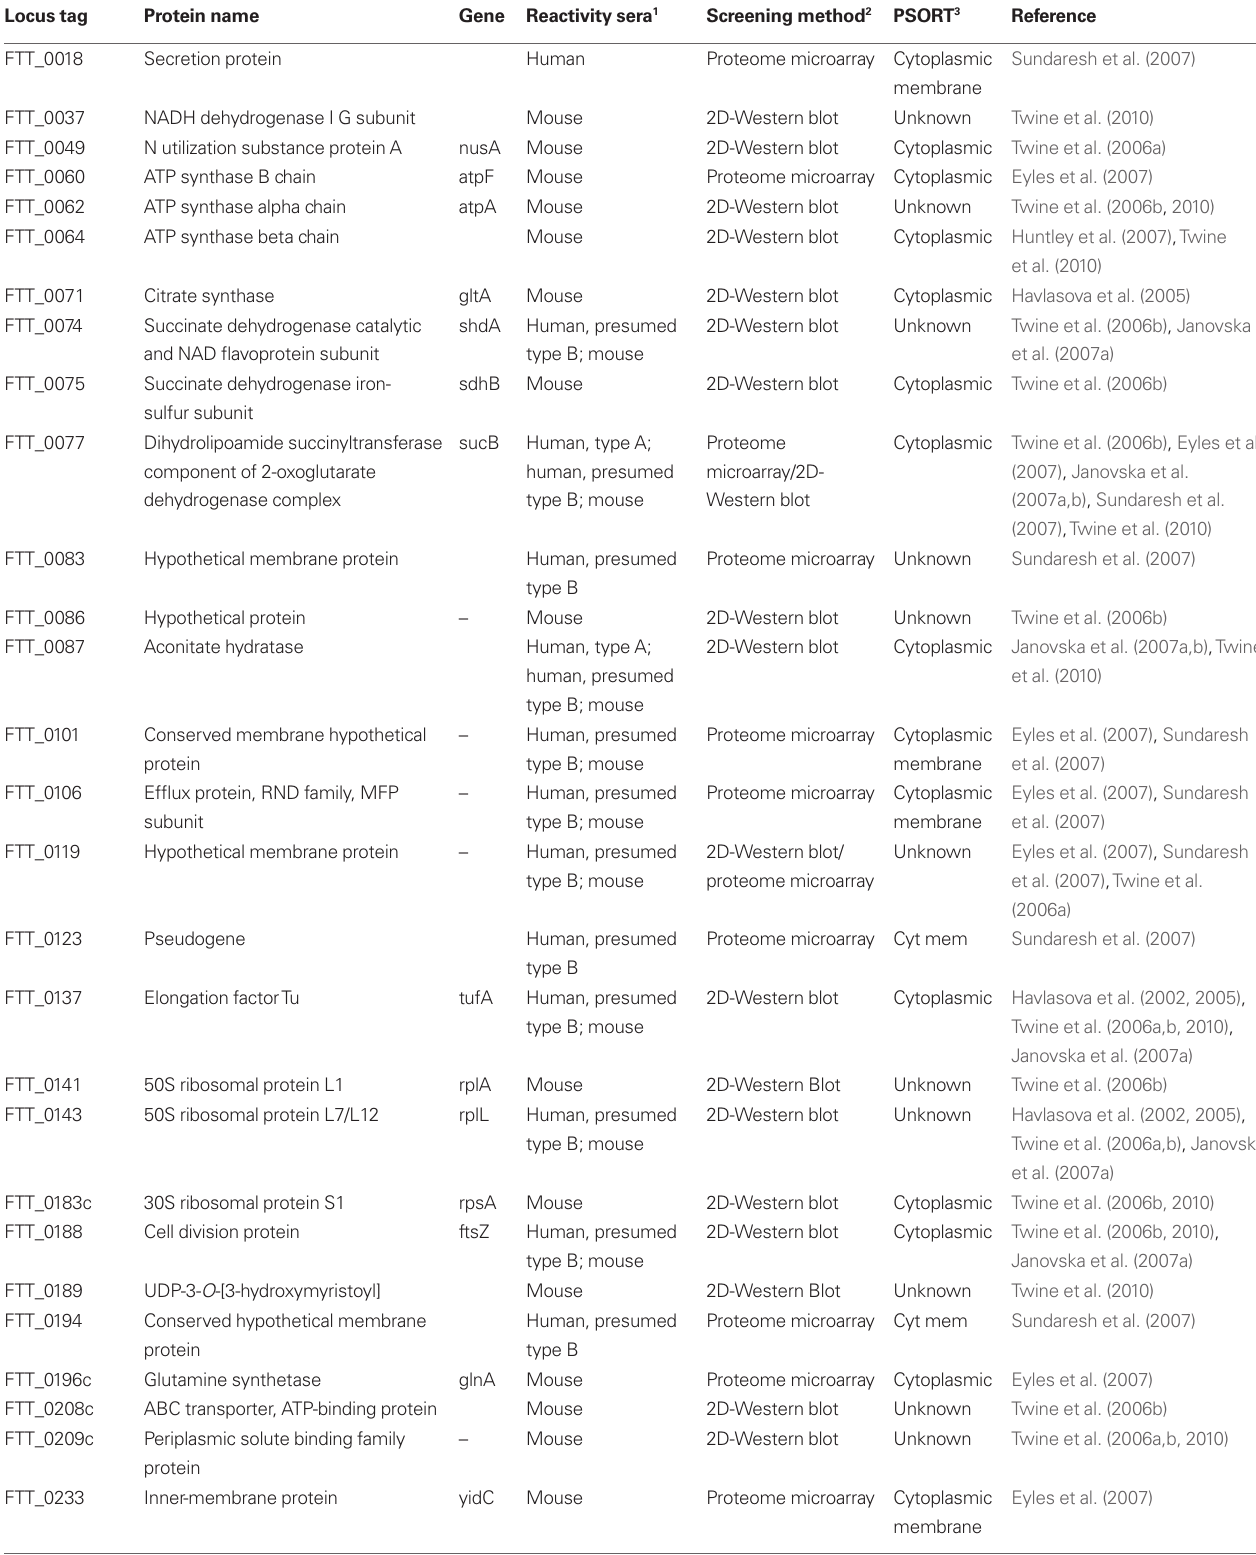
Table 3 | Proteins which are recognized by sera from convalescent humans or from LVS vaccinated mice. Locus